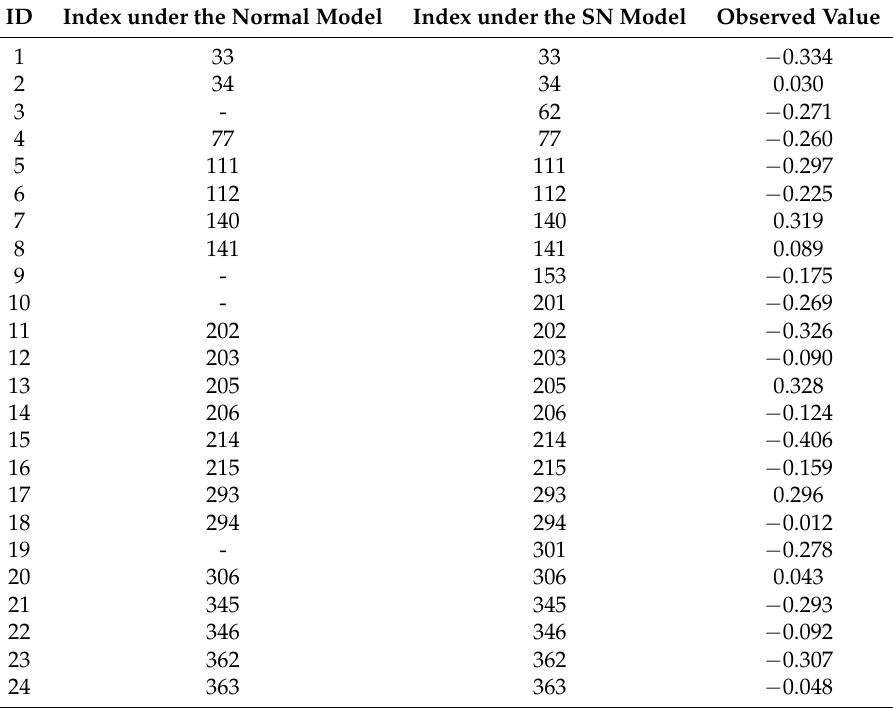
Figure 2. Diagnostics for the perturbations of case-weights, data, variance and skewness. Table 1. Local influence results for normal and SN